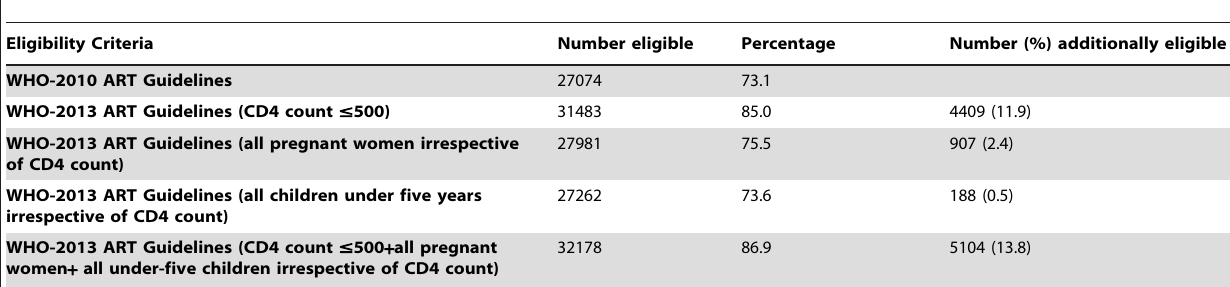
Table 3. Number of HIV-infected people eligible for ART as per the current and new WHO criteria for ART initiation, Karnataka State, India, 2012 (N =37044*).